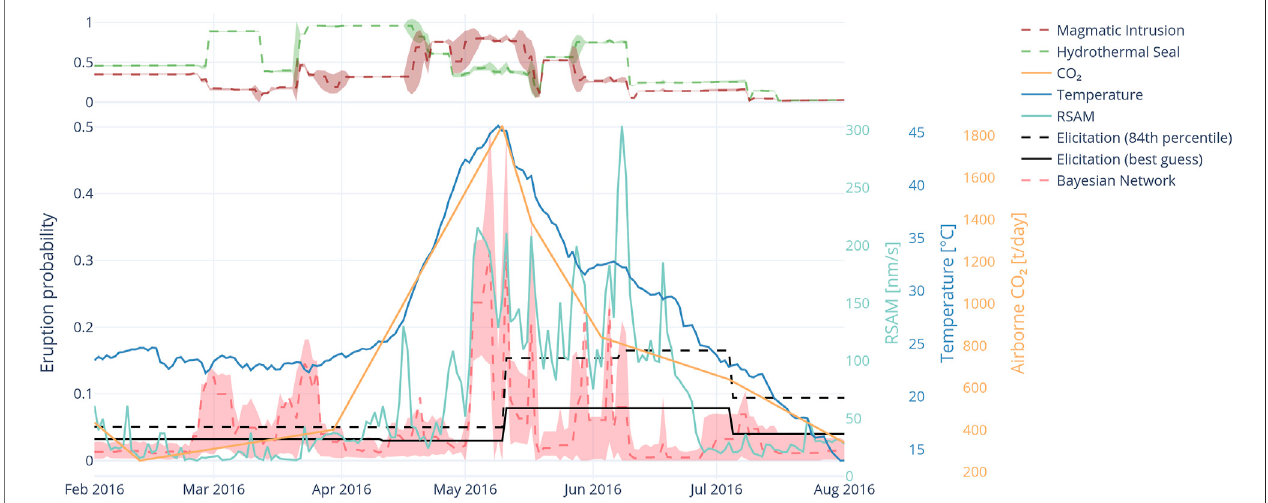
FIGURE 9 | BN timeseries from February to August 2016 covering period of high crater lake temperature. Pink shading indicates 90% con fi dence interval around themeanoftheBNforecast(reddashed line).Correspondingbestguessand84thpercentile valuesfromVMGelicitationsshowninblackcurves.Laketemperatureand RSAM are shown by blue and green curves respectively. The top panel indicates the values of the hidden BN nodes, magmatic intrusion (red dashed line) and hydrothermal seal (green dashed line), with shading showing the 90% con fi dence interval.